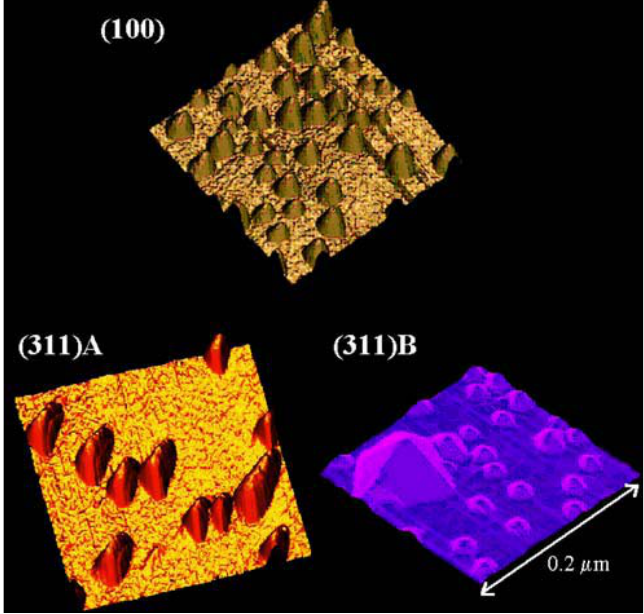
Figure 5. STM image of InAs/GaAs QDs grown by MBE on GaAs. Reprinted with permission from